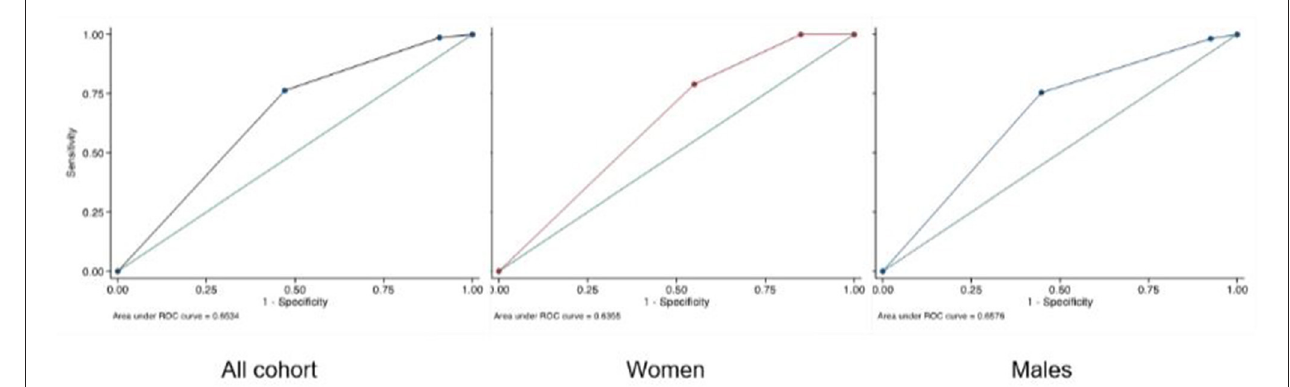
FIGURE 2 | AUC of SCAI classification.